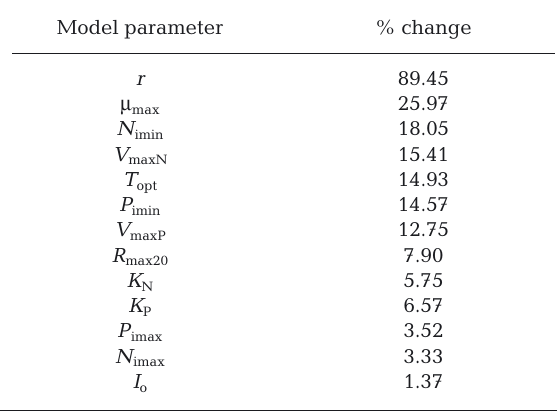
Table 2. Sensitivity analyses as percent relative change from the baseline of dry weight of cultured Saccharina japonica predicted by the kelp growth model after changing each model parameter by ±10% (except T min changed only +10%